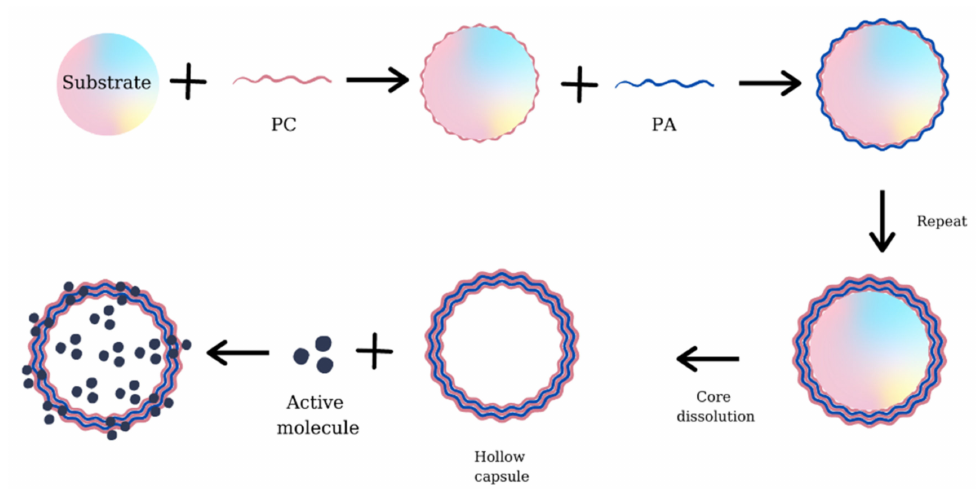
Figure 7. The mechanism of obtaining LbL hollow capsules and their use in the encapsulation of active